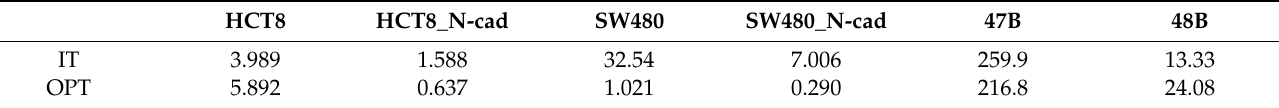
Table 1. IC50 values ( µ g/ mL) of irinotecan (IT) and oxaliplatin (OPT) treatment in original SW480 and HCT8 cell lines, their N-cadherin-transfected variant SW480_N-cad, resp. HCT8_N-cad and two colon cancer primocultures 47B and 48B isolated from patient’s samples after 48 h treatment. Data are expressed as an average ±